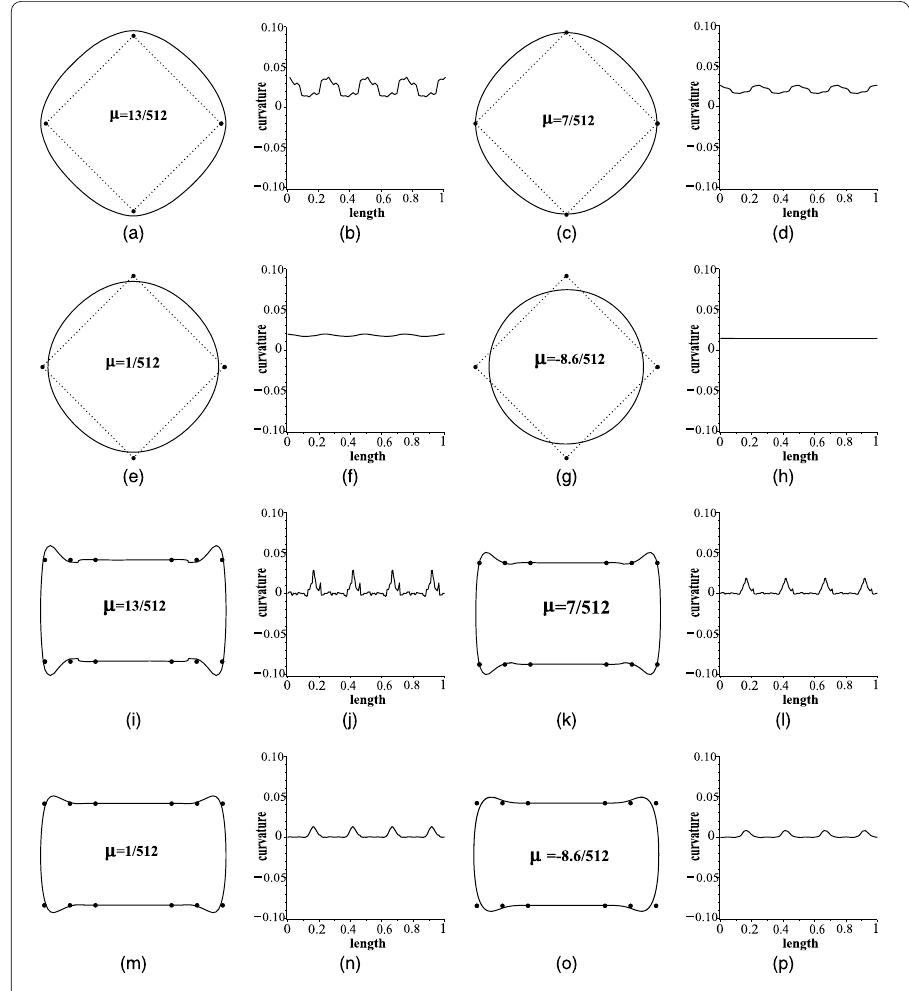
Figure 3 Four subdivision levels of SS (17) have been used to the control polygon. The results after different values of μ are shown on the left together with their corresponding curvature on the